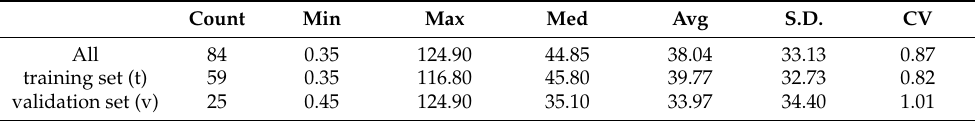
Table 5. Descriptive statistics of the soil EC